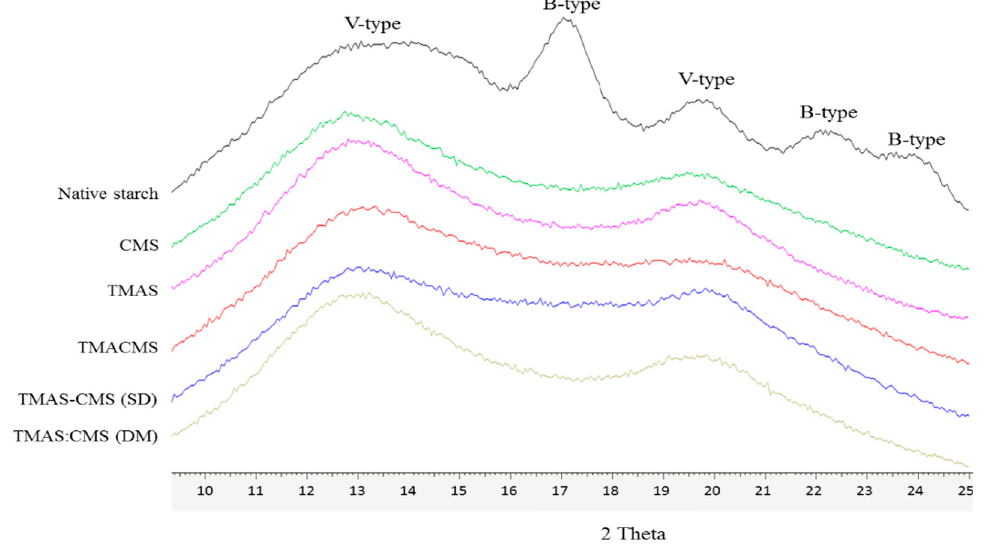
Figure 2. X-ray diffraction patterns of native starch (Hylon VII), and of CMS, TMAS, TMACMS, TMAS-CMS (spray drying (SD)), and TMAS:CMS (dry mixed (DM)) starch products.